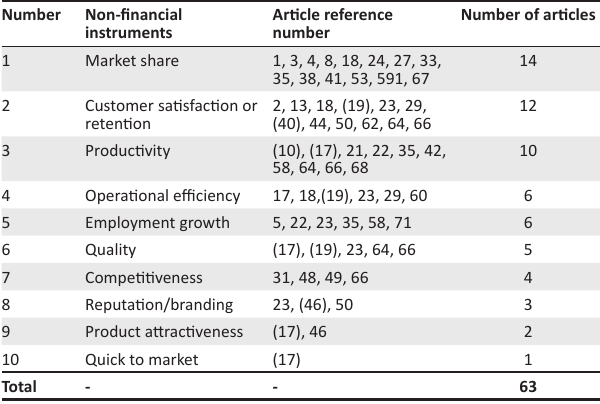
TABLE 3: Non-financial instruments used to measure organisational